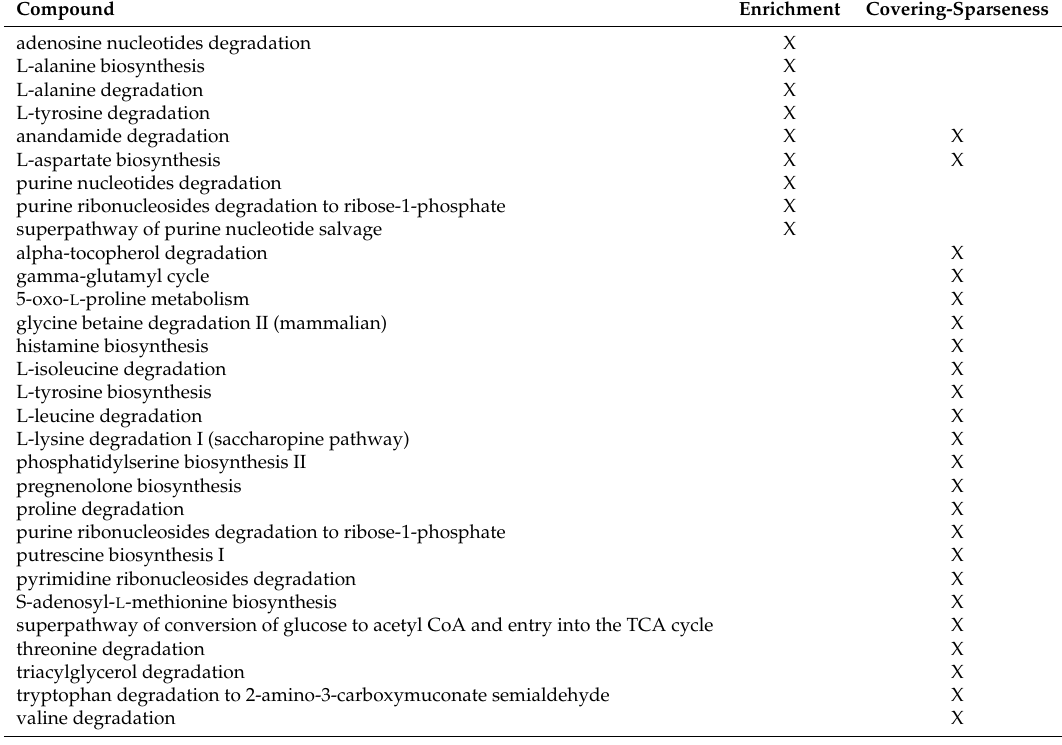
Table 4. Comparison of ST000061 Pathway Enrichment to Pathway Covering using Covered Compound Sparseness.